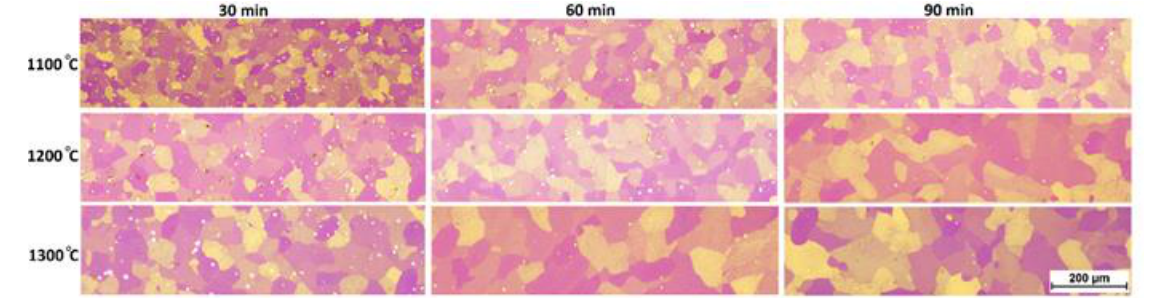
Figure 13. Nine microstructural images of the width cross section of the sintered titanium